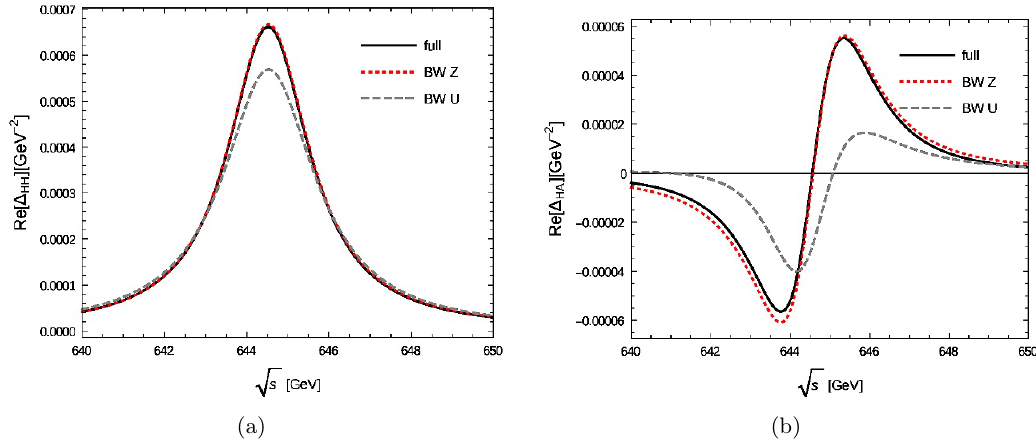
Figure 10 . Comparison of the full propagators (black, solid) with the Breit-Wigner approximations based on the U -matrix (grey, dashed) and ^ Z -matrix (red, dotted) for real parts of the diagonal propagator (cid:1) HH ( p 2 ) (a) and the o(cid:11)-diagonal (cid:1) HA ( p 2 ) (b) depending on the real momentum p 2 = s p around s ’ M h ; M h 2 3